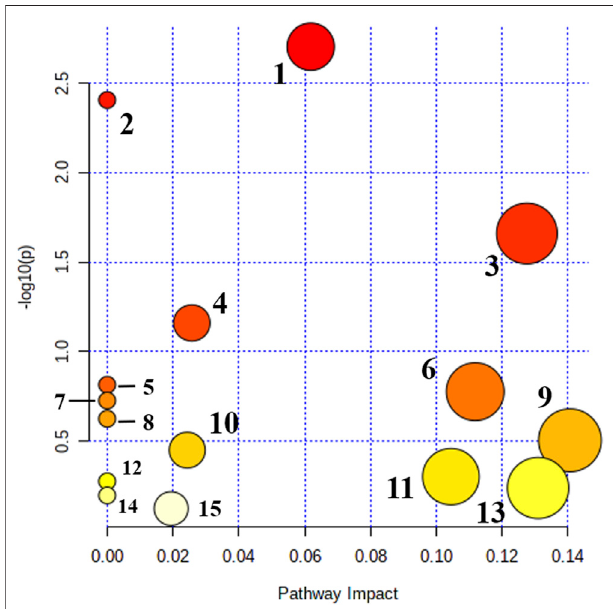
FIGURE3| Main metabolic pathways ofpotentialbiomakers. 1.Primary bile acid biosynthesis; 2. Linoleic acid metabolism; 3. Porphyrin and chlorophyll metabolism; 4. Steroid hormone biosynthesis; 5. Taurine and hypotaurine metabolism; 6. Glycerophospholipid metabolism; 7. Ascorbate and aldarate metabolism; 8. alpha-Linolenic acid metabolism; 9. Pentose and glucuronate interconversions; 10. Sphingolipid metabolism; 11. Cysteine and methionine metabolism; 12. Arachidonic acid metabolism; 13. Tryptophan metabolism; 14. Aminoacyl-tRNA biosynthesis; and 15. Purine